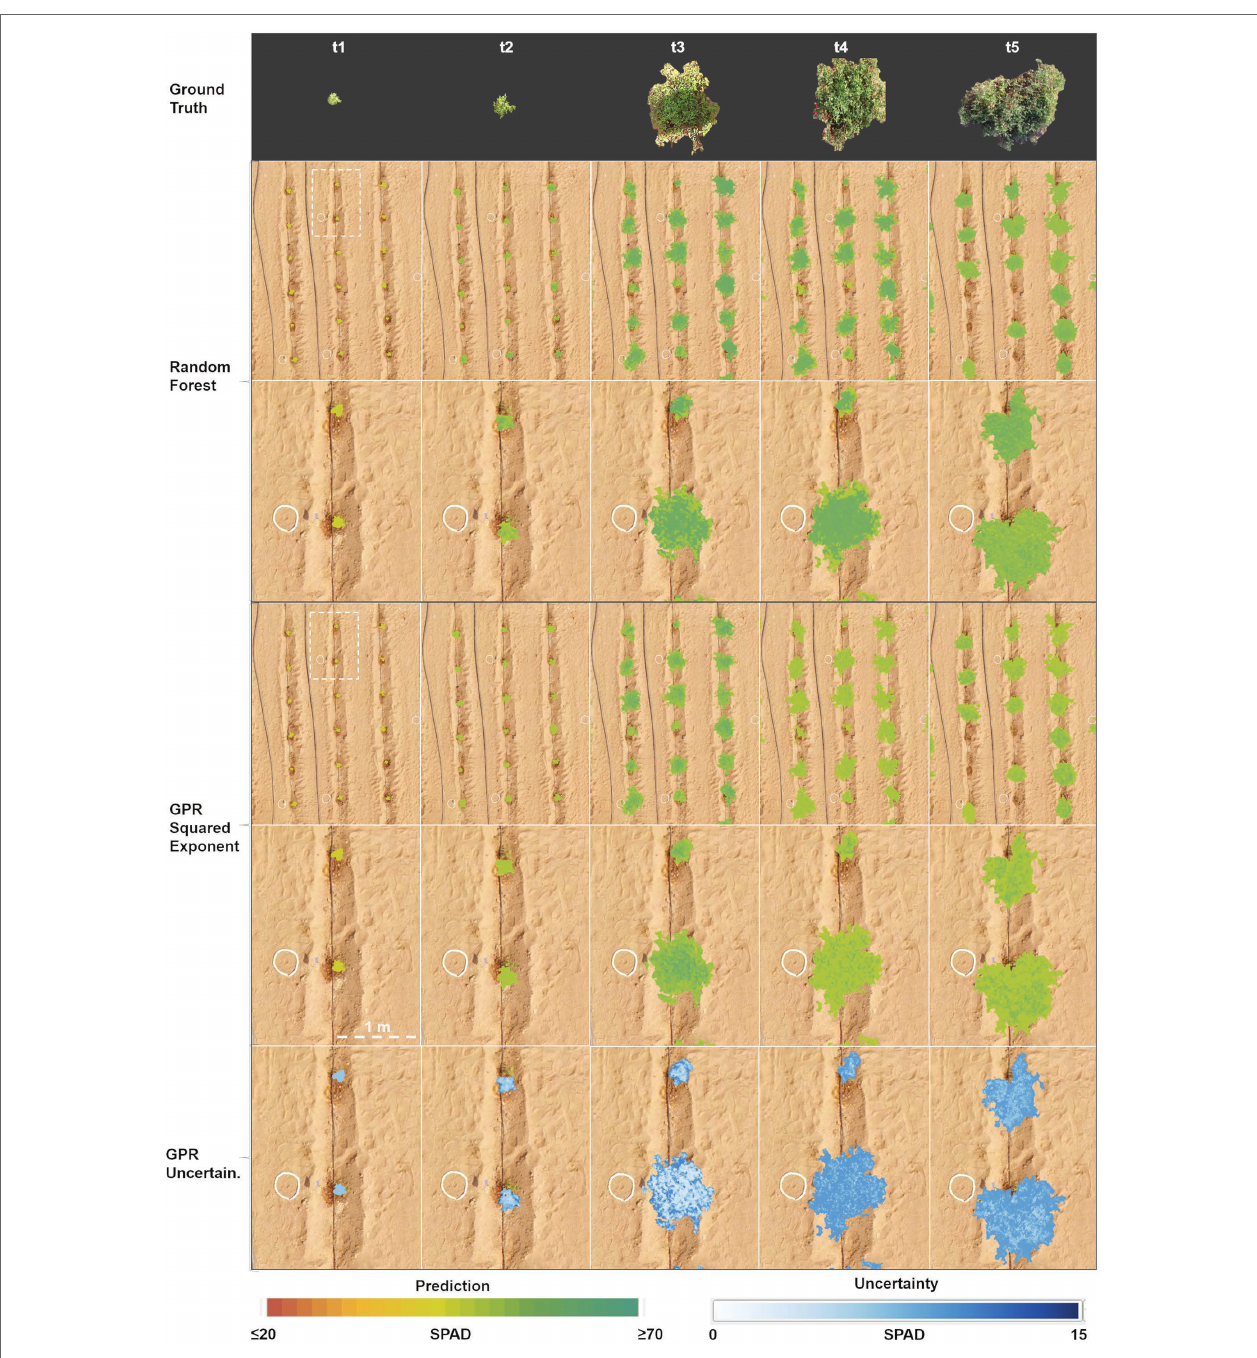
FIGURE 9 | Comparison of multi-temporal SPAD prediction maps generated with PLSR coupled with band predictors, random forest and GPR squared exponential models, using vegetation indices predictors (lower panels). True color-balanced pictures of a showcase plant (upper panel) depict changes throughout the growing cycle. The gradient-colored bars represent the estimated SPAD values in the range between 20 to 70 units, with a bin size of 2. The SPAD uncertainties are shown in the range between 0 to 15 units, with a bin size of